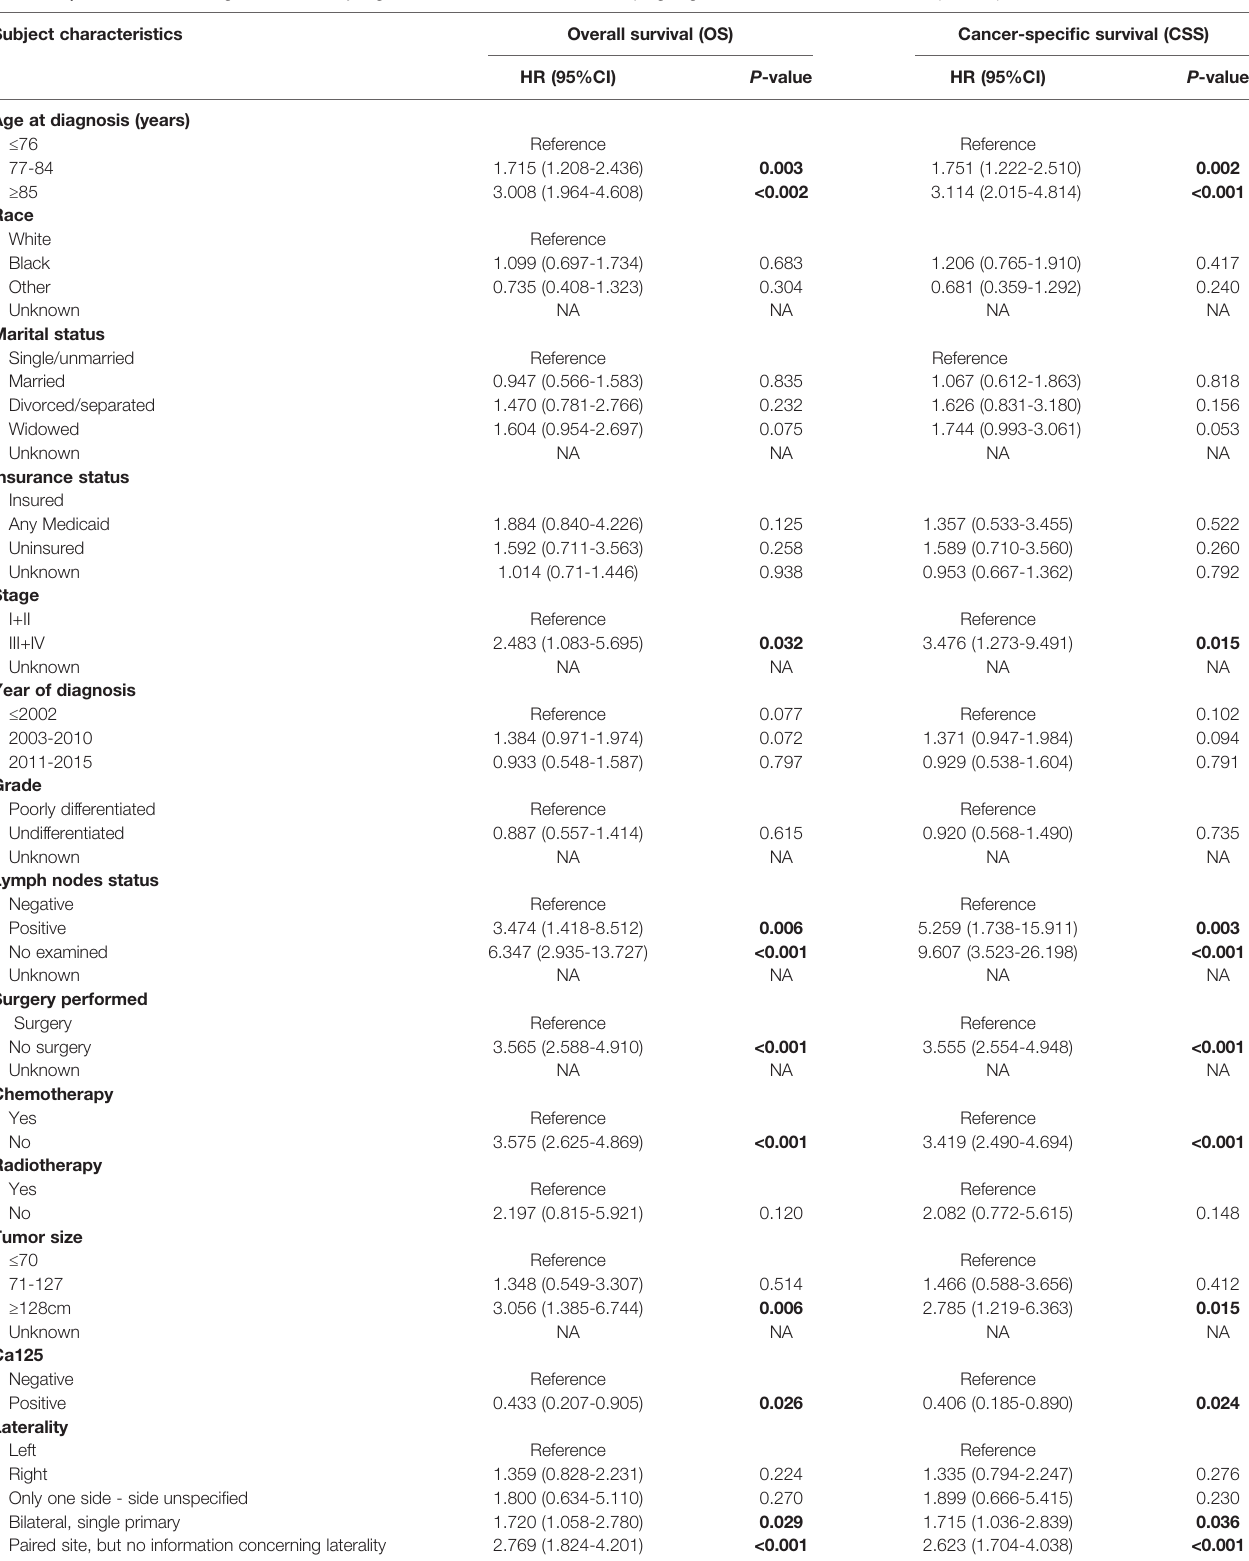
TABLE 2 | Univariable Cox Regression for analyzing the associated factors for developing large cell carcinoma of the ovarian